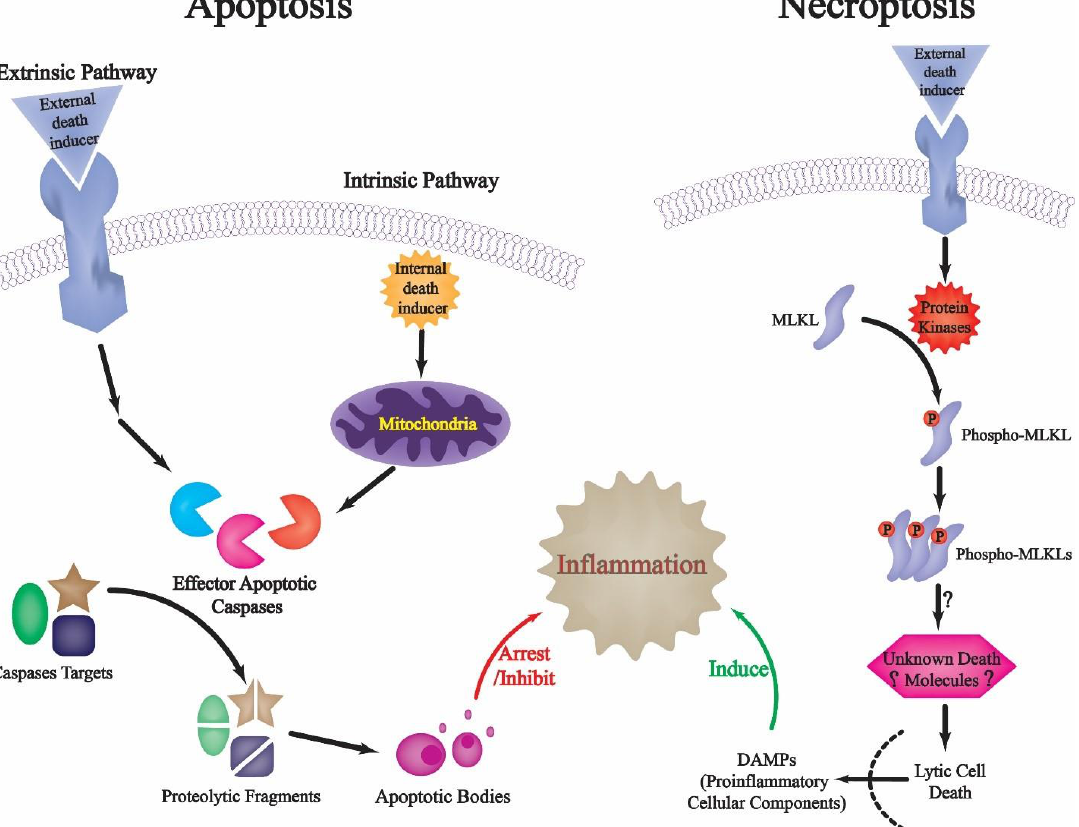
Figure 2. Two distinct mechanisms of cell death and impact on inflammation. In apoptosis, caspases cleave diverse signaling target substrate proteins that fine-tune the cell-death process. In necroptosis, protein kinases mediate the phosphorylation of MLKL, thereby activating it. Phospho-MLKL then leads to cell lysis that culminate in inflammatory-related roles.